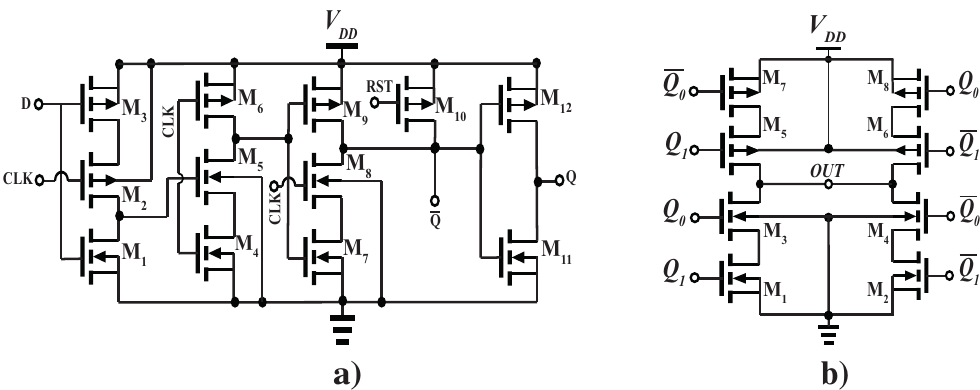
Figure 12. ( a ) Schematic of the TSPC D-FF and ( b ) schematic of the XOR Gate used for the proposed